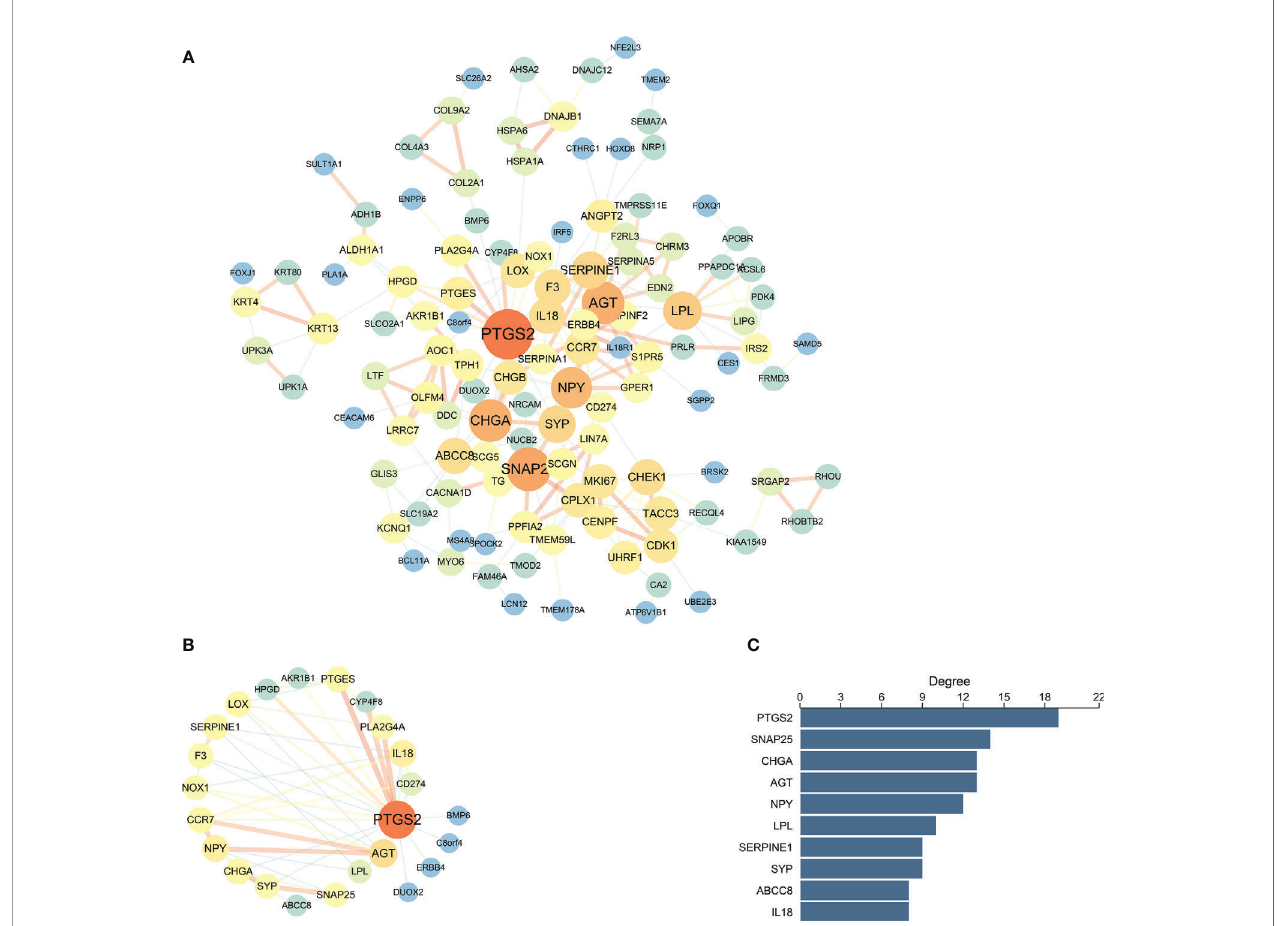
FIGURE 3 | PPI network analysis of the DEGs. (A) The connection among DEGs. (B) Sub-PPI network of the top 10 hub genes in DEGs. The larger circles and blue to pink color correspond to the higher degrees between genes, and the wider line and blue to pink color refer to the increasing of the combined score. (C) The levels of degree for the top 10 hub genes in